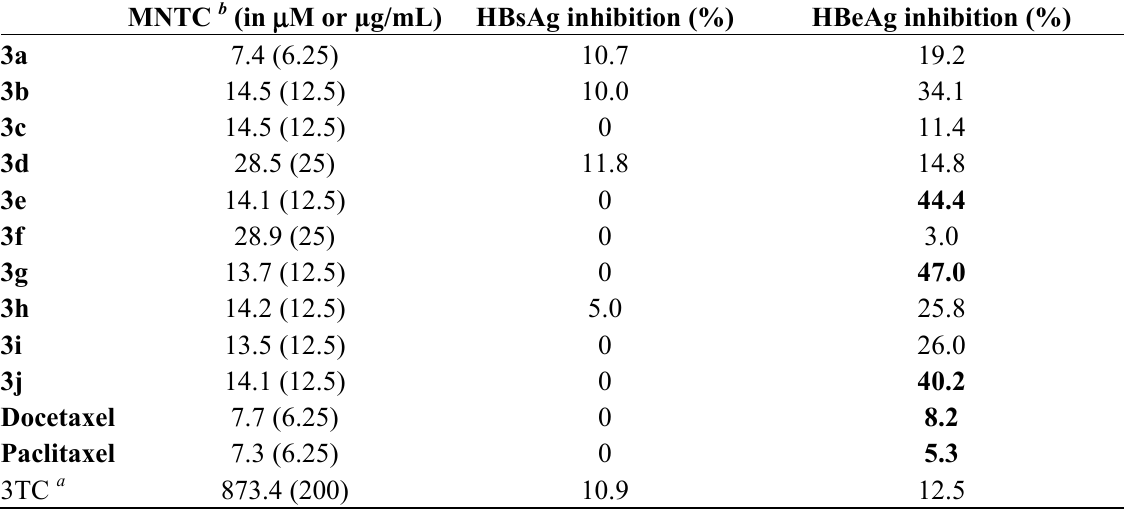
Table 1. Anti-HBsAg and anti-HBeAg effects of compounds 3a – j in HepG2 2.2.15 cell